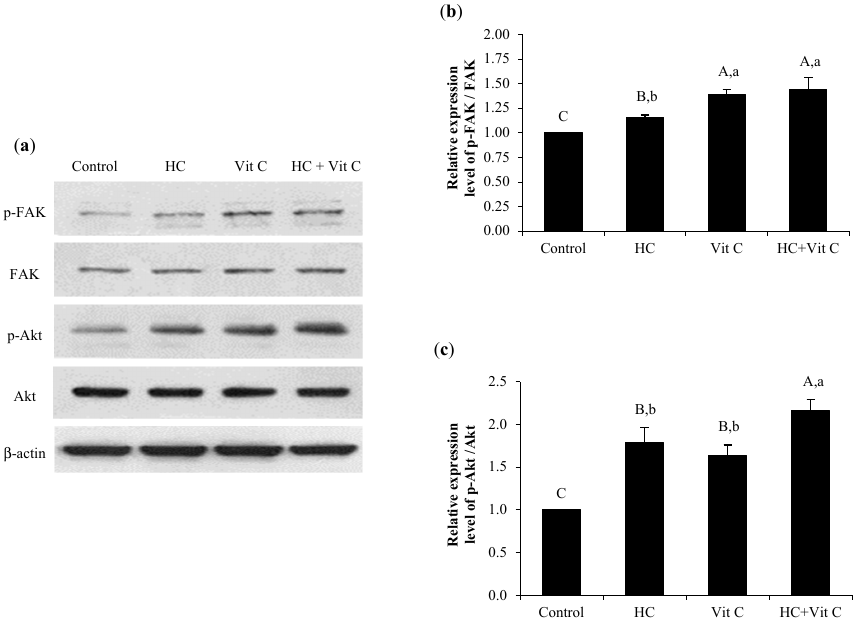
Figure 6. Effect of HC, Vit C, and HC combined with Vit C (HC+Vit C) at the selected levels on the expression of p-FAK and p-Akt proteins ( a ) and relative level of p-FAK ( b ) and p-Akt ( c ) in HDF cells after treatment with the samples for 24 h. Bars represent standard deviation ( n = 3). Different uppercase letters on bars indicate significant differences between different samples tested and control ( p < 0.05). Different lowercase letters on bars indicate significant differences among different samples tested ( p < 0.05).